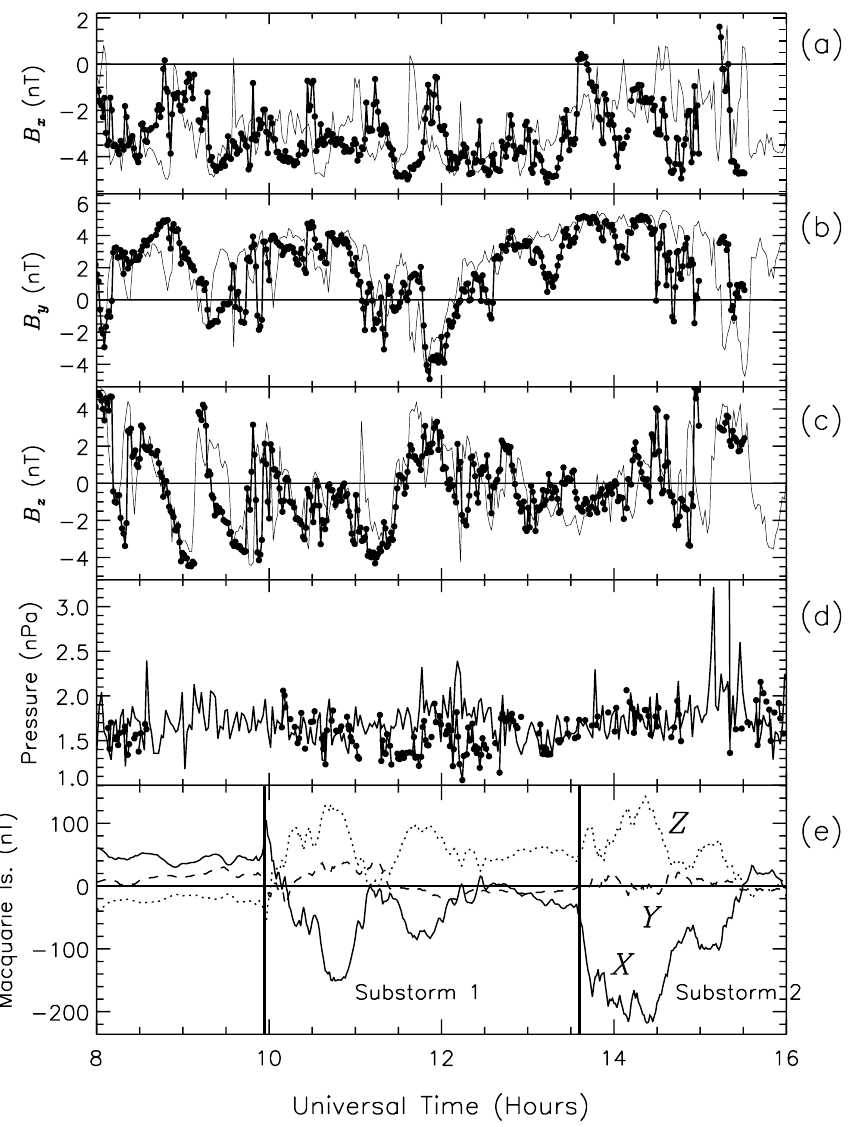
Fig. 2. IMP 8 spacecraft measurements (bold lines with solid dots) of the IMF (a) B x , (b) B y , and (c) B z components made at ∼ 1-min time resolution, and (d) the solar wind dynamic pressure during 08:00 to 16:00UT on 27 February 2000. The corresponding Wind spacecraft measurements made at ∼ 1.5-min time resolution for the same period, except advanced by 33.5min to allow for advection of the solar wind to the location of IMP 8, are superimposed as faint curves. (e) Perturbations of the geomagnetic X (solid curve), Y (dashed curve), and Z (dotted curve) components measured by the MQI magnetometer (data provided courtesy of the Australian Geological Survey Organisation). The abscissas have tick marks at 30-min intervals of